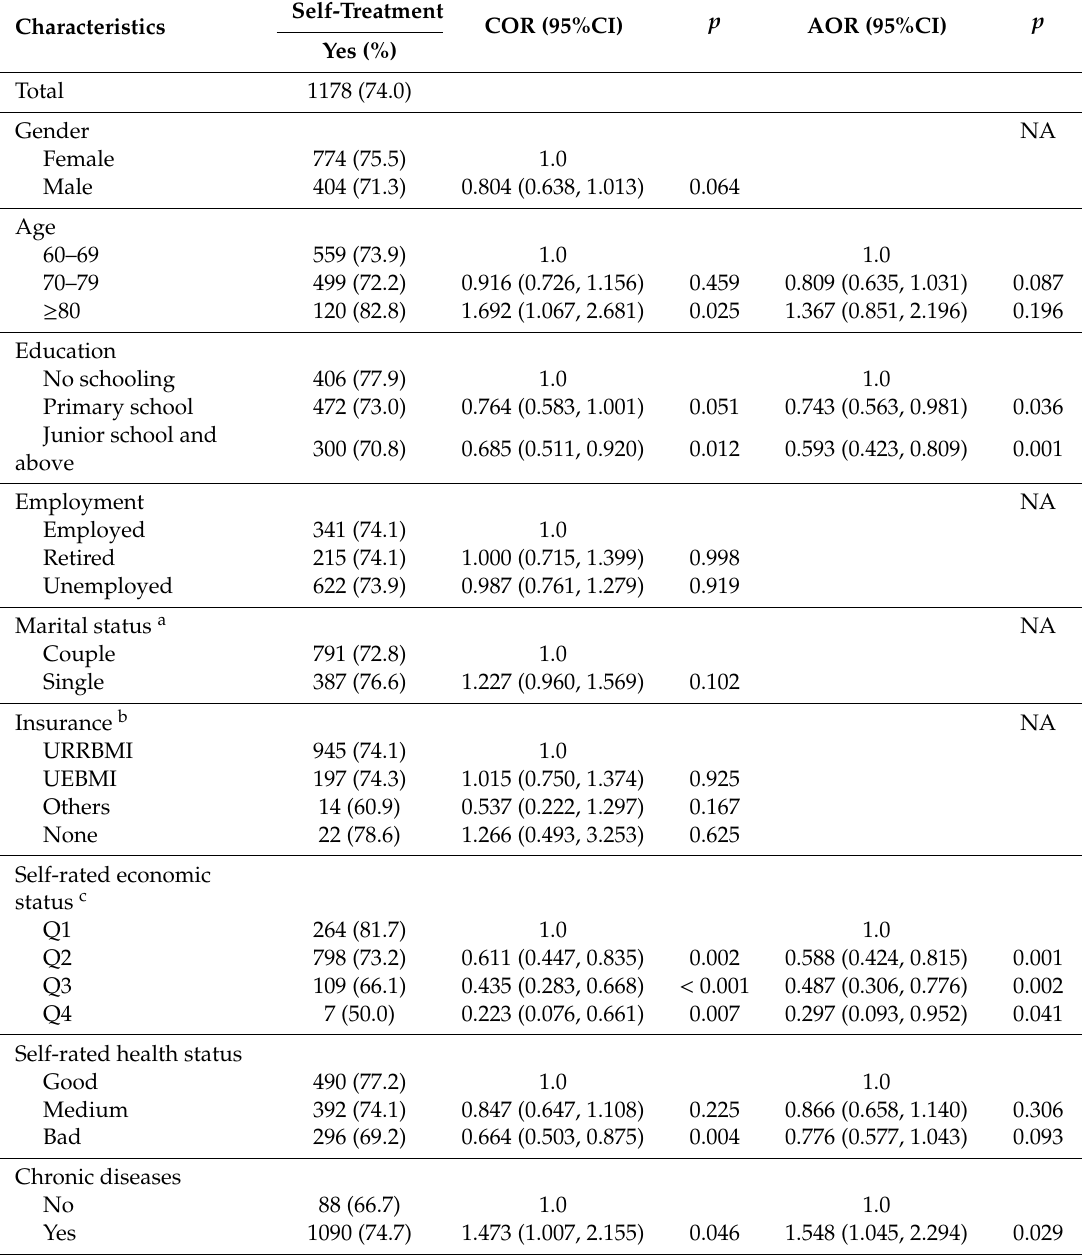
Table 3. Factors with self-treatment among empty nesters in Shandong. China. ( n = 1592).